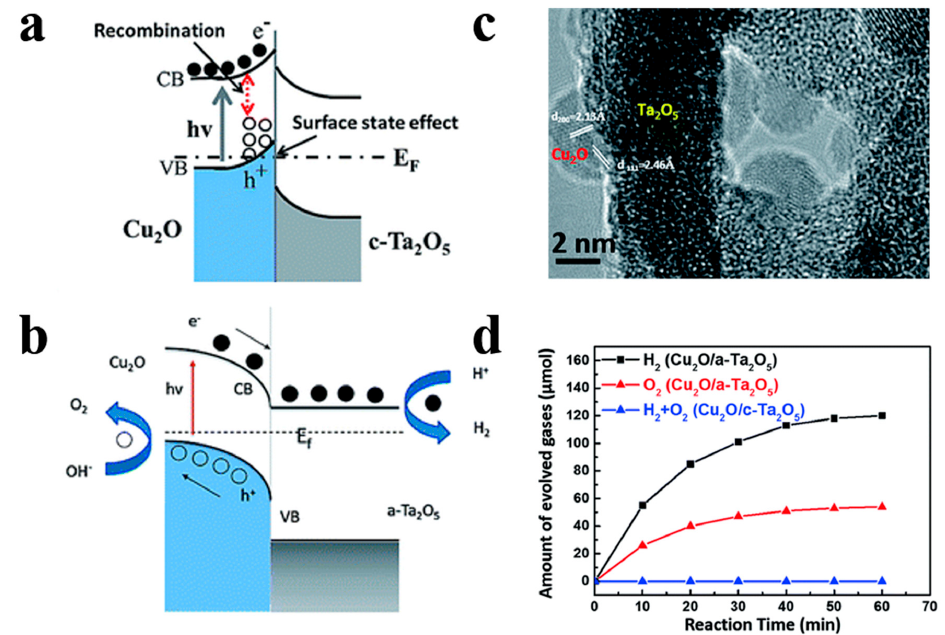
Figure 12. ( a ) Band bending diagram of Cu 2 O / crystalline Ta 2 O 5 . ( b ) Band bending diagram of Cu 2 O / amorphous Ta 2 O 5 nanoheterojunctions. ( c ) HRTEM image of Cu 2 O / amorphous Ta 2 O 5 heterostructures. ( d ) Amount of evolved gases under full light for different samples. Reproduced with permission from [82]. Copyright Royal Society of Chemistry, 2017.